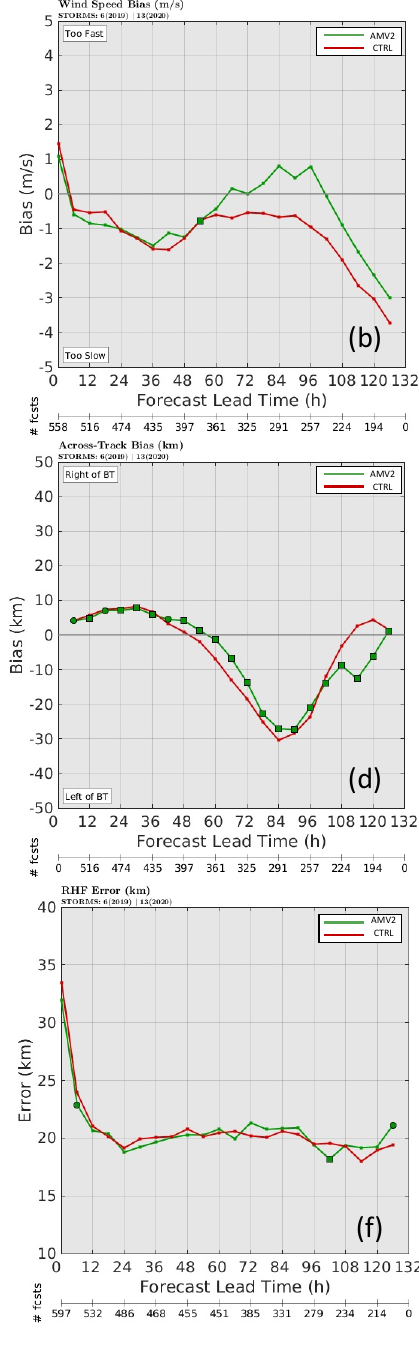
Figure 12. Verification statistics for the 2019 and 2020 hurricane seasons in the Atlantic Ocean for control (red) and experiment AMV2 (green). AMV2 assimilates hourly SWIR and VIS as well as high-temporal AMVs for all five wind types. It also uses the new QCs and error profiles. Panel ( a ) is wind speed error measured using maximum sustained 10 m winds [m/s], ( b ) is wind speed bias [m/s], ( c ) is track error [km], ( d ) is across track bias [km], ( e ) is radius of tropical storm-force (RTSF) wind error [km], and ( f ) is radius of hurricane-force (RHF) wind error [km]. Squares (circles) indicate statistical significance at the 95% (90%) confidence level based on a paired t -test with adaptive serial correlation. The number of samples used in deriving these statistics is shown in the secondary axis.